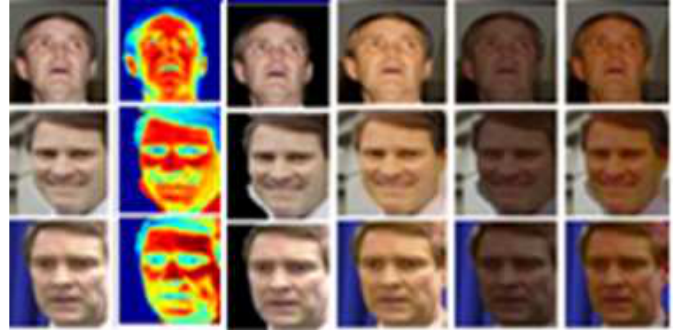
Figure 3. The scene illustration by process of conditional random field (CRF) transferred to our proposed